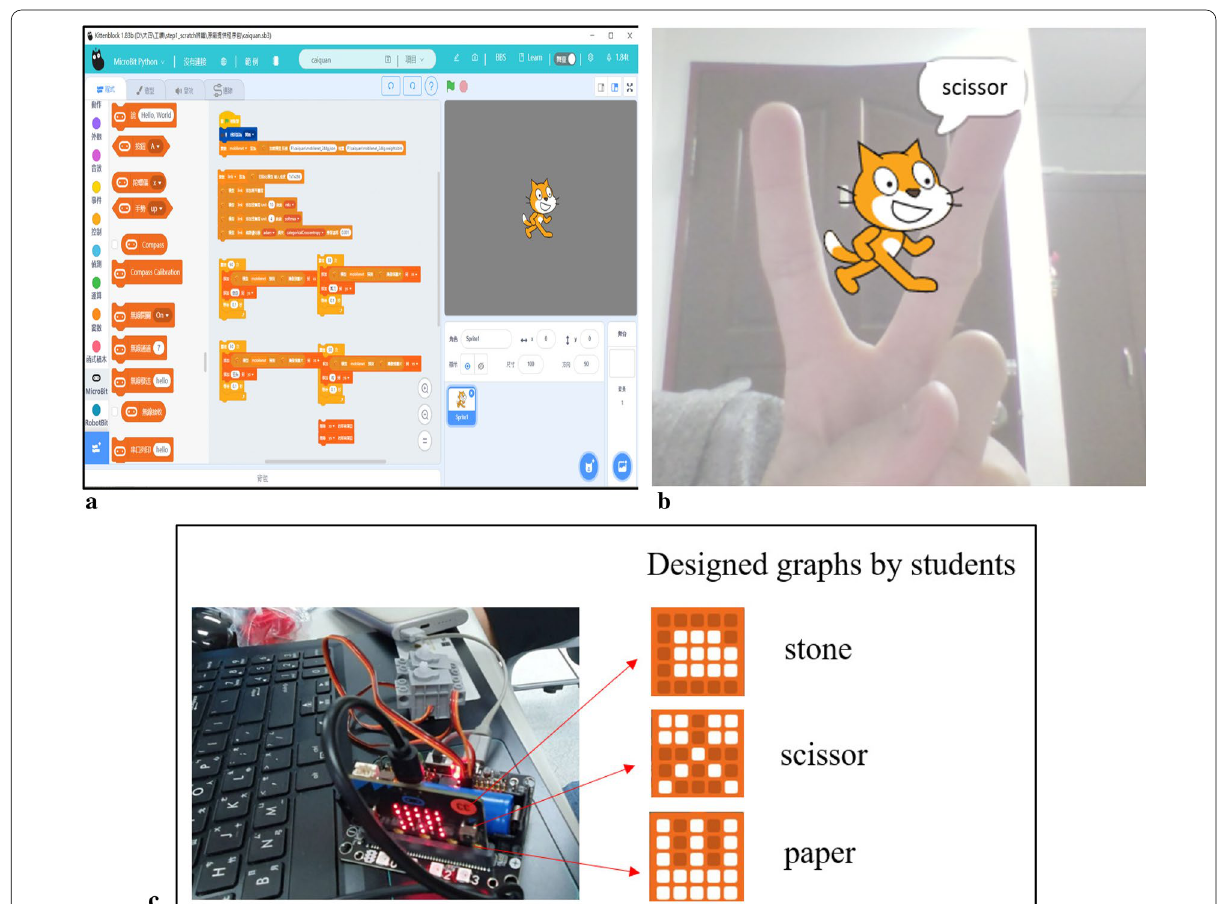
Fig. 5 a Coding the program in Kittenblock. b AI program can recognize user’s gestures (blank,scissors, rock, paper) in real time through webcam image. c Designed graphs by students in the STEAM